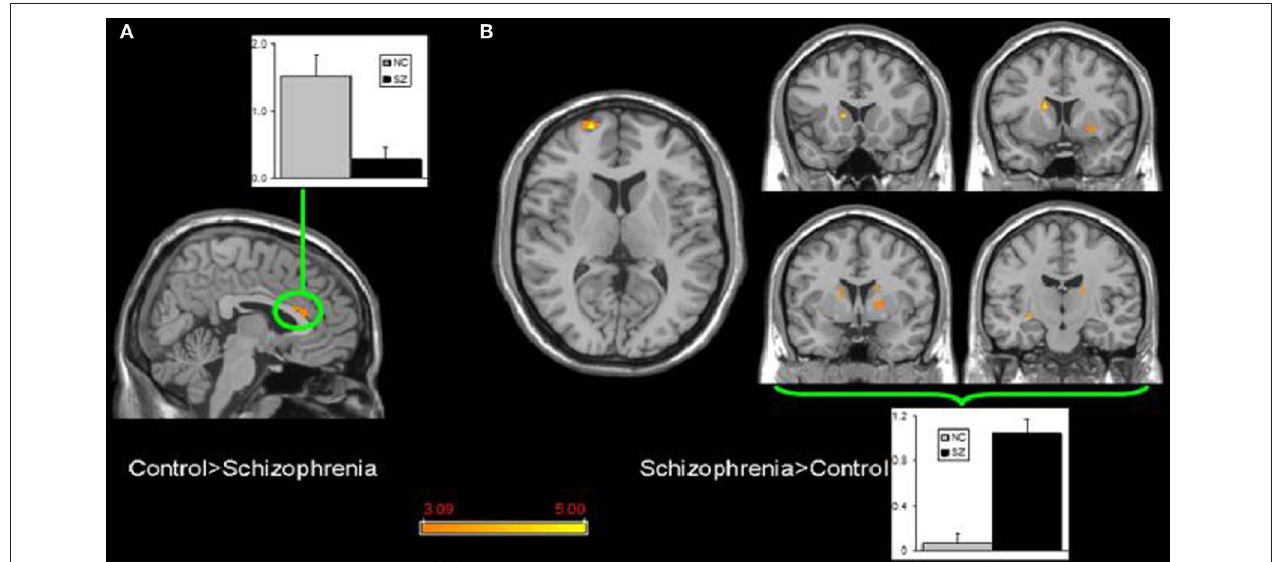
FIGURE 6 | Significant differences in the default mode network spatial extent between normal control and schizophrenia subjects in whole brain analysis mapped onto parasagittal, coronal, and axial slices from a single subject’s structural image in Talairach space; (A) Normal control > Schizophrenia where the only finding is in the anterior cingulate cortexr; (B) Schizophrenia > Normal control where multiple clusters are seen